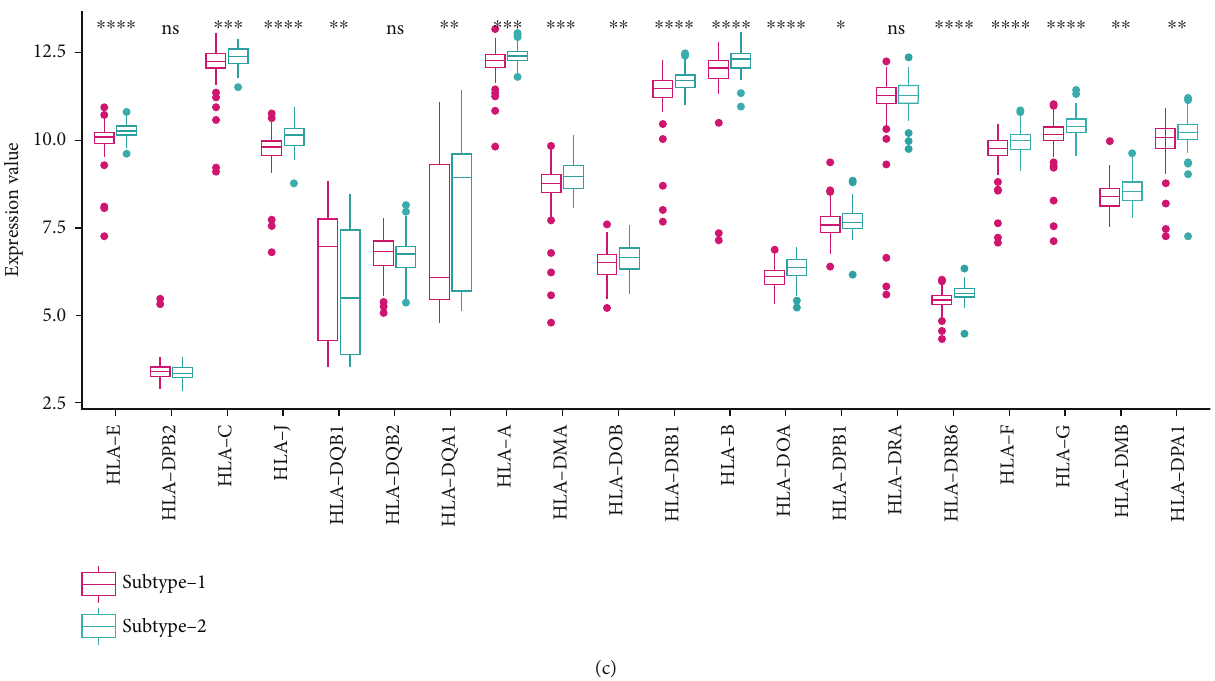
(Table S1-S12) were uploaded entitled “ Table S1: signi fi cantly dysregulated RBPs .txt. ” “ Table S2: results of univariate logistic regression.txt. ” “ Table S3: results of multivariate logistic regression.txt. ” “ Table S4: diversity of immunocytes between healthy and periodontitis samples.txt. ” “ Table S5: correlation analysis between immnuocytes and RBPs.txt. ” “ Table S6: diversity of immune pathways between healthy and periodon- titis samples.txt. ” “ Table S7: Correlations between RBPs and immune pathways.txt. ” “ Table S8: diversity of HLA expression